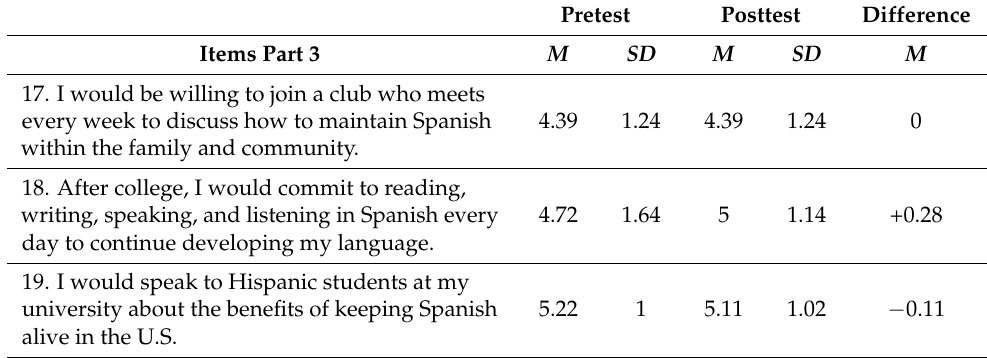
Table 5. Mean and Standard Deviation Results for CLA Questionnaire Part 3 ( N = 18).